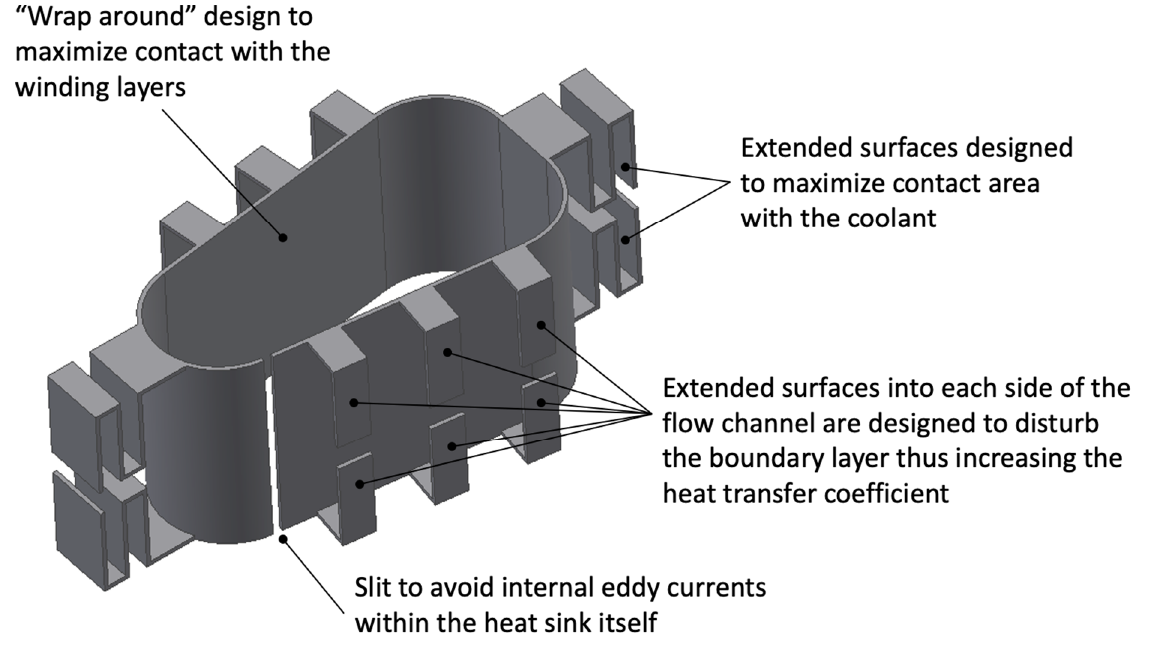
Figure 11. CAD model for the heat sink.